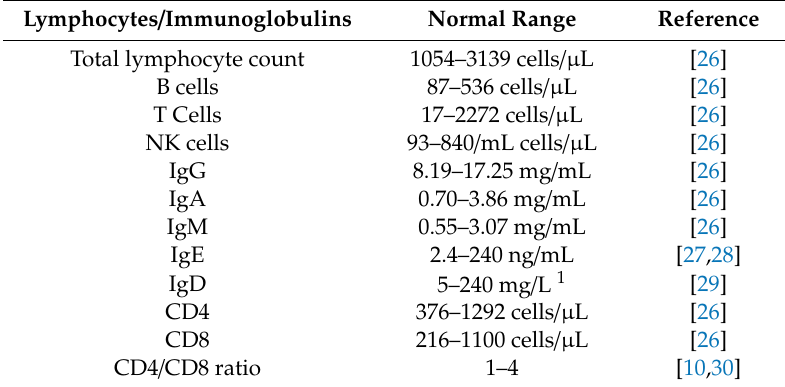
Table 1. Reference intervals for lymphocytes and immunoglobulins in human